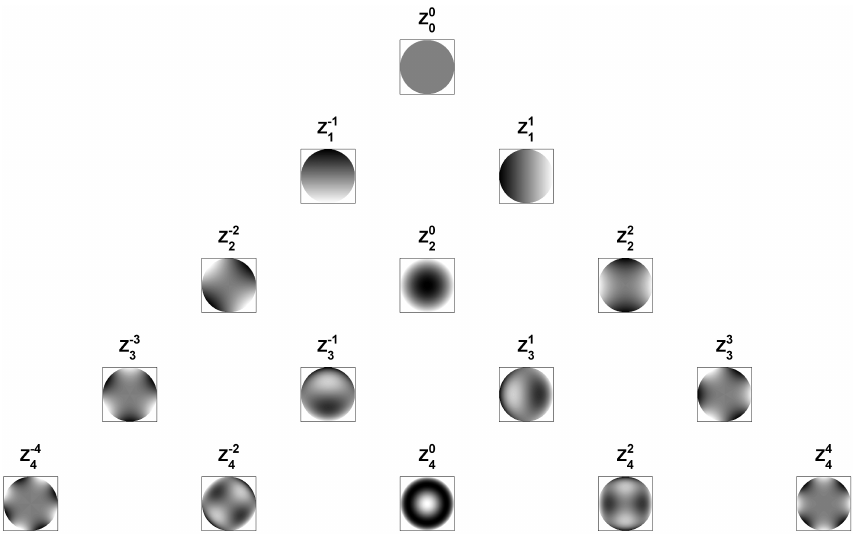
Fig. 3. Usual representation of the Zernike polynomials evaluated on the unit disk up to order n =4. If m> 0, the real part is represented. If m< 0, the imaginary part is